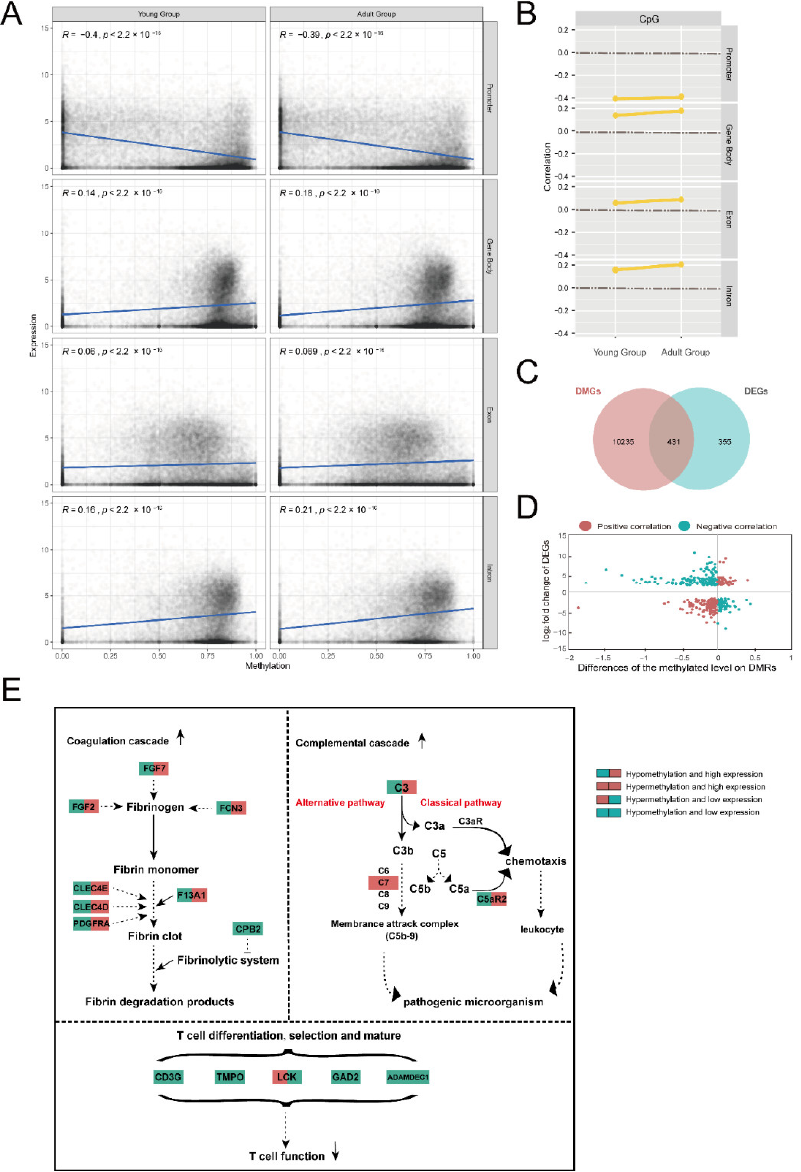
Figure 4. Relationship between methylation and expression. ( A ) Dot chart showing the methylation pairs stratified by age in columns and feature type in rows with 30,807 genes. Each dot represents the mean methylation level of the CpGs within the feature across all samples of that age on the x- axis and the log 2 ([mean TPM] + 1) for the promoters, gene bodies, exons and introns on the y-axis. Linear regression with shaded standard error and the rho for each correlation is listed for each plot with Pearson’s method. ( B ) Correlation of feature expression and methylation stratified by cytosine context (columns) and feature type (rows). ( C ) Venn diagram depicting the DEGs, DMGs and shared genes. ( D ) Quadrant diagram showing the distribution of DMGs and DEGs (red (positive correlation): hypermethylation with a high expression level and hypomethylation with low expressions level; green regions (negative correlation): hypermethylation with a low expression level and hypomethylation with a high expression level). ( E ) KEGG and GO enrichment map of the complement system; coagu- lation cascade; and T cells differentiation, activation and maturation by DEGs and DMGs in the thy- mus. Green in the left of the box and red in the right of the box: hypomethylation and high expression; red in the whole box: hypermethylation and high expression; red in the left of the box and green in the right of the box: hypermethylation and low expression; green in the whole box: hypomethylation and low expression in the thymuses of the adult group compared with the young group.